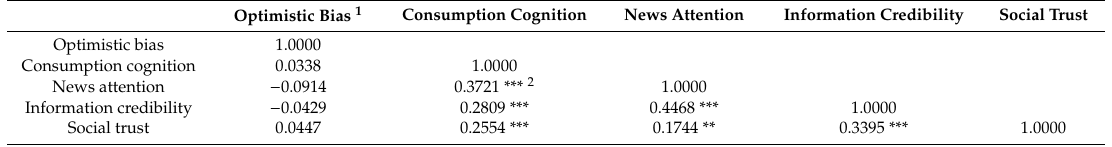
Table 3. Correlation coe ffi cients between variables in Taiwan sample